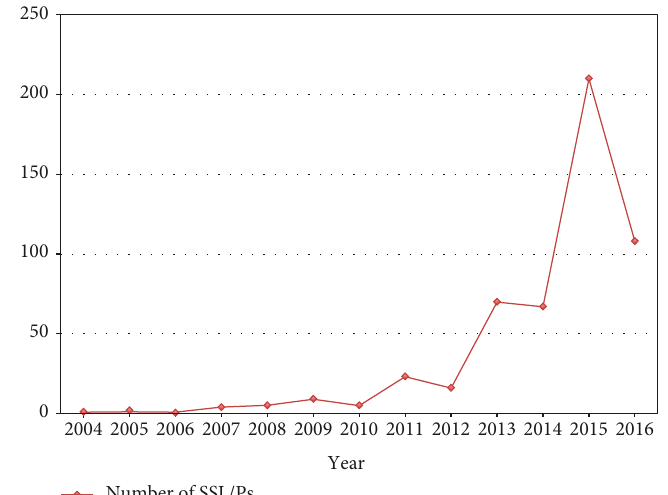
Figure 3: The number of SSL/Ps detected between January 1 st 2004 and May 31 st 2016, with detection of SSL/Ps peaking in the most recent years included in this review (87.5% reported between 2013 & 2016, inclusive). This coincided with the introduction of “ BowelScreen ” (the Irish colorectal cancer screening programme).